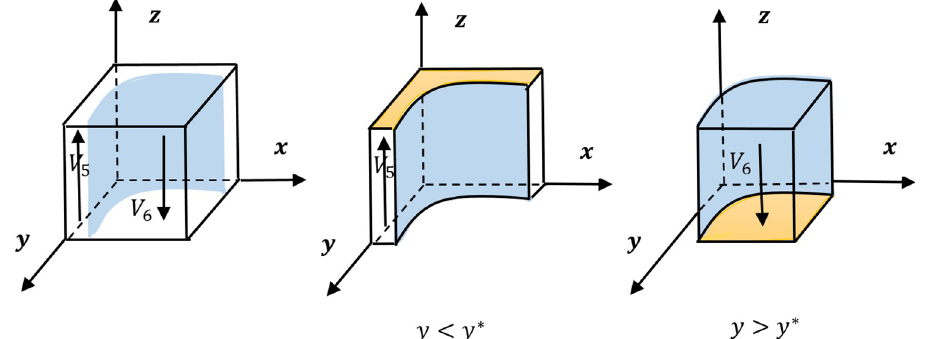
Fig 3. The evolution trend diagram of the ordinary